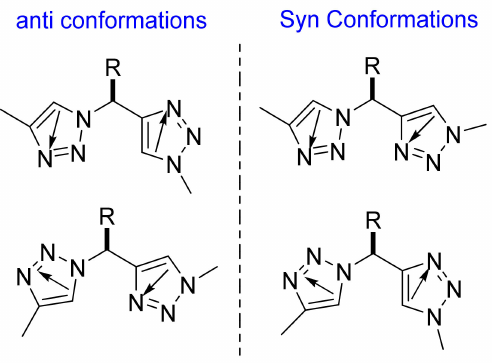
Figure 9. The possible anti-conformations and syn-conformations adopted by the triazole